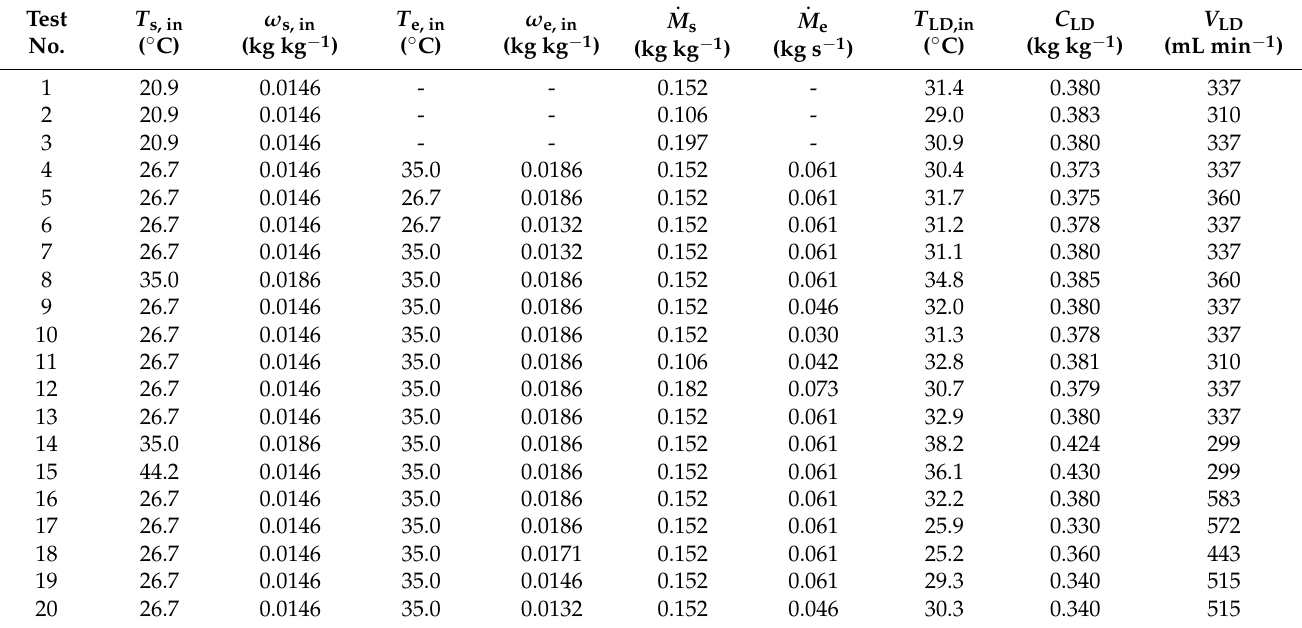
Table A1. Experimental test conditions